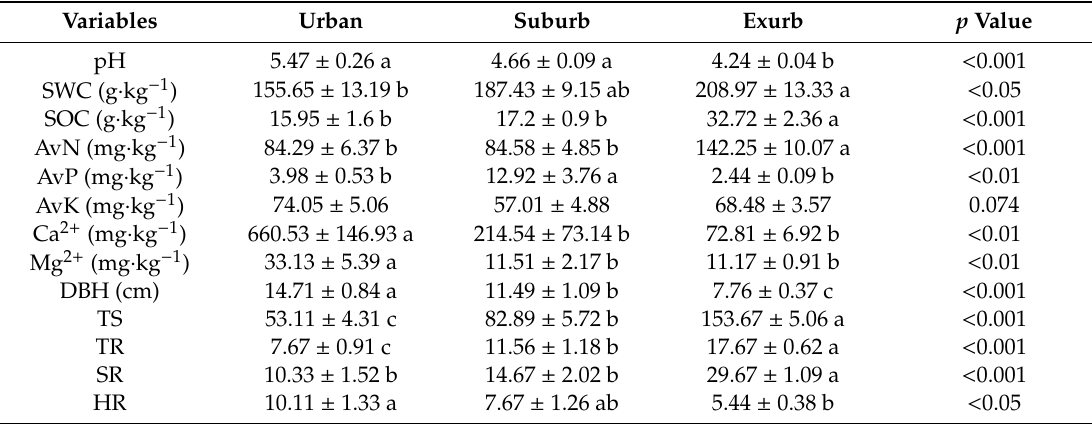
Table 2. Characteristics of plant and soil along the urban-to-rural